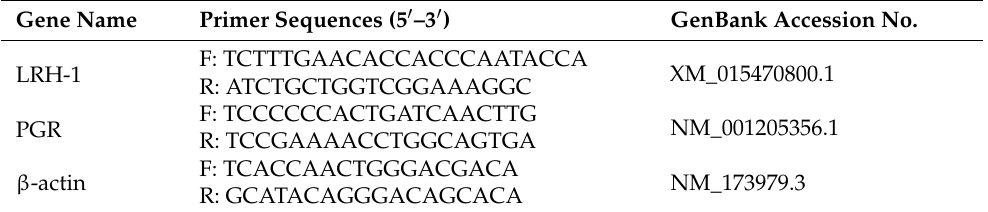
Table 1. Sequences for primers used in quantitative real-time